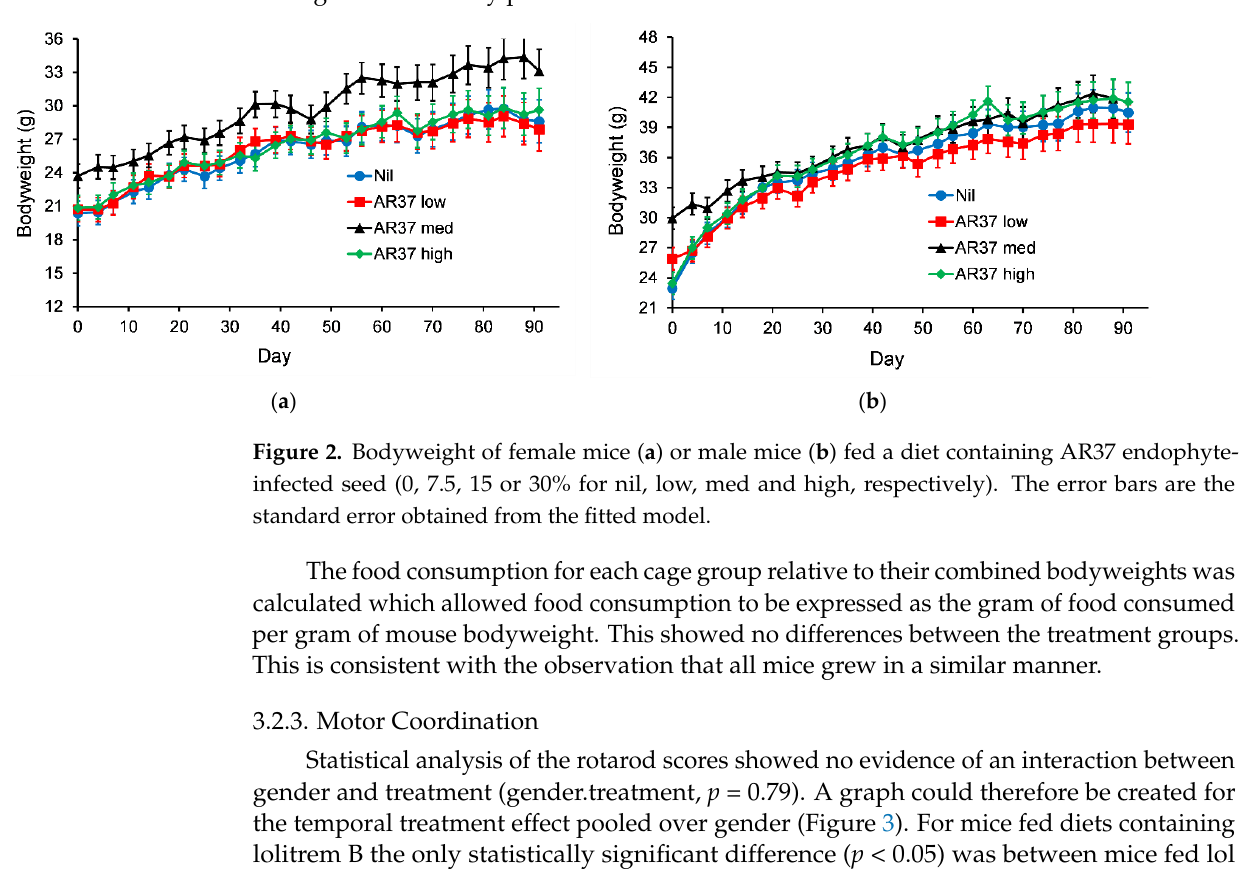
tained throughout the 90-day period.